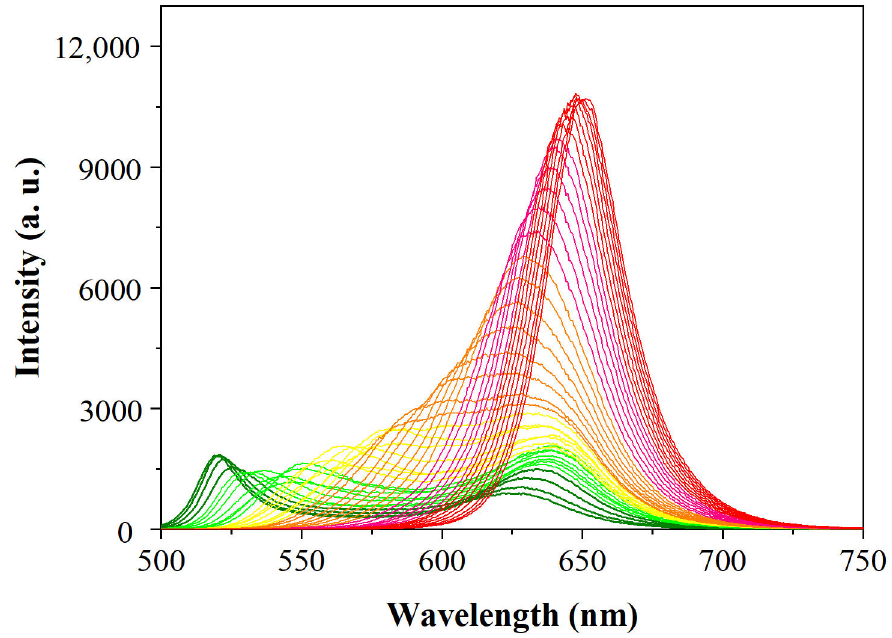
Figure 5. Fluorescence spectra of halide exchanges between CsPbBr 3 PNCs in n-hexane and NaI powder.